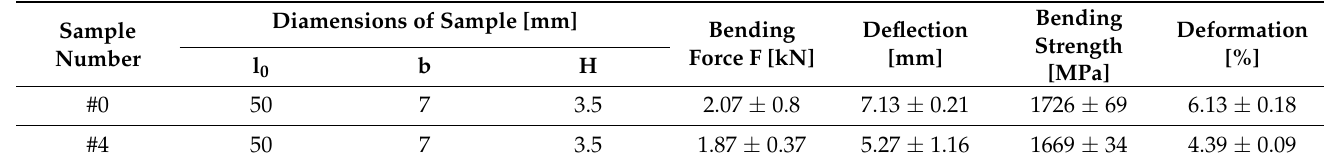
Table 2. The results of static bending test.